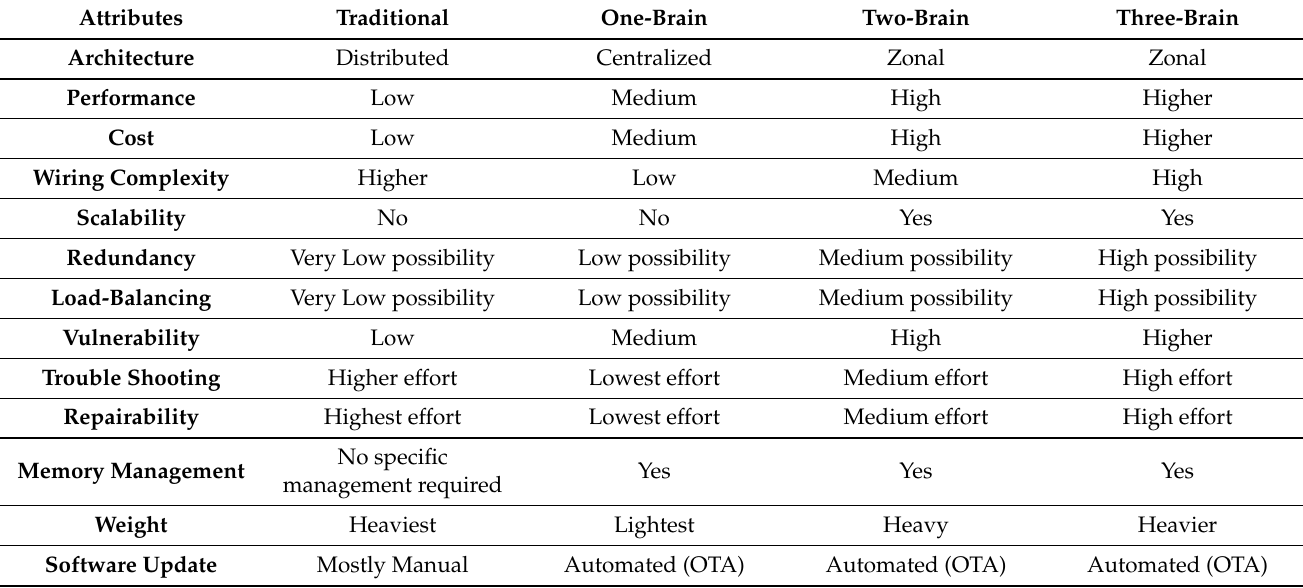
Table 3. Comparison Representation of Different E/E